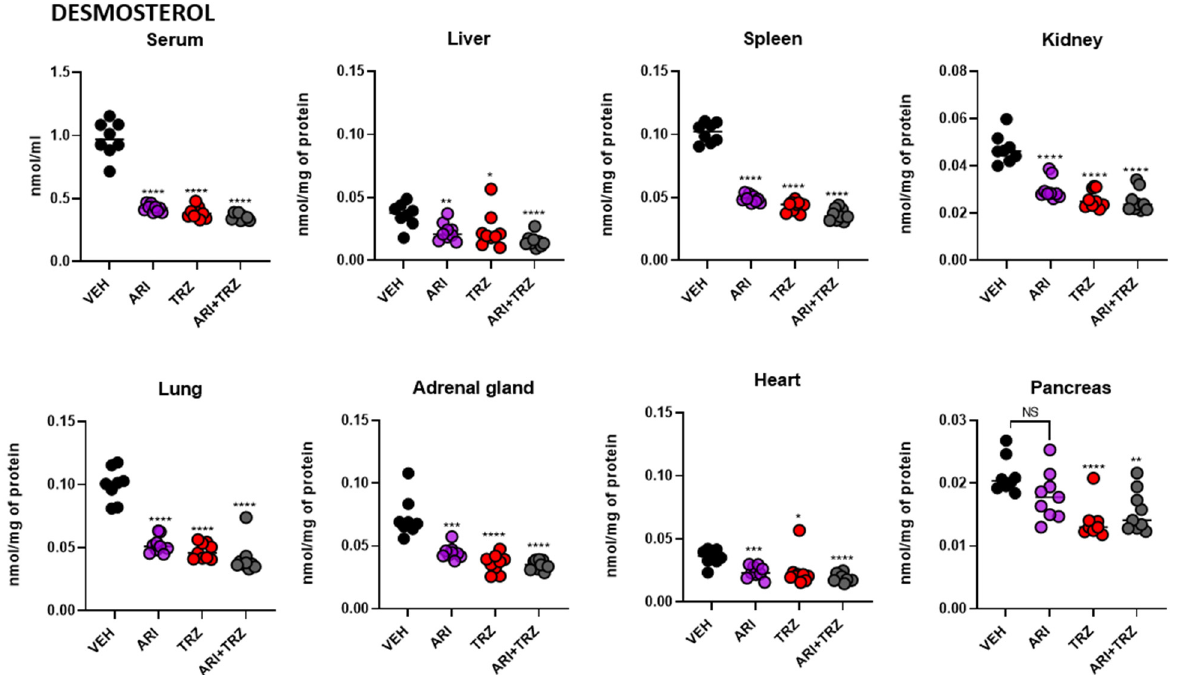
Figure 6. ARI and TRZ treatment effects on DES levels in the serum and seven peripheral organs of mice. Each symbol represents a sample from a single mouse. X axis represents treatment groups, Y axis represents DES concentration normalized to nmol/mL (in the case of serum) or nmol/mg of protein. Black asterisk denotes comparison to untreated baseline levels. Two-tailed groupwise t -test was used for statistical comparisons, * p < 0.05, ** p < 0.01, *** p < 0.001, **** p < 0.0001. Note the strong DES decrease by all treatments. Percentage of DES decrease for each sample type is presented in Figure S5, lower panel.